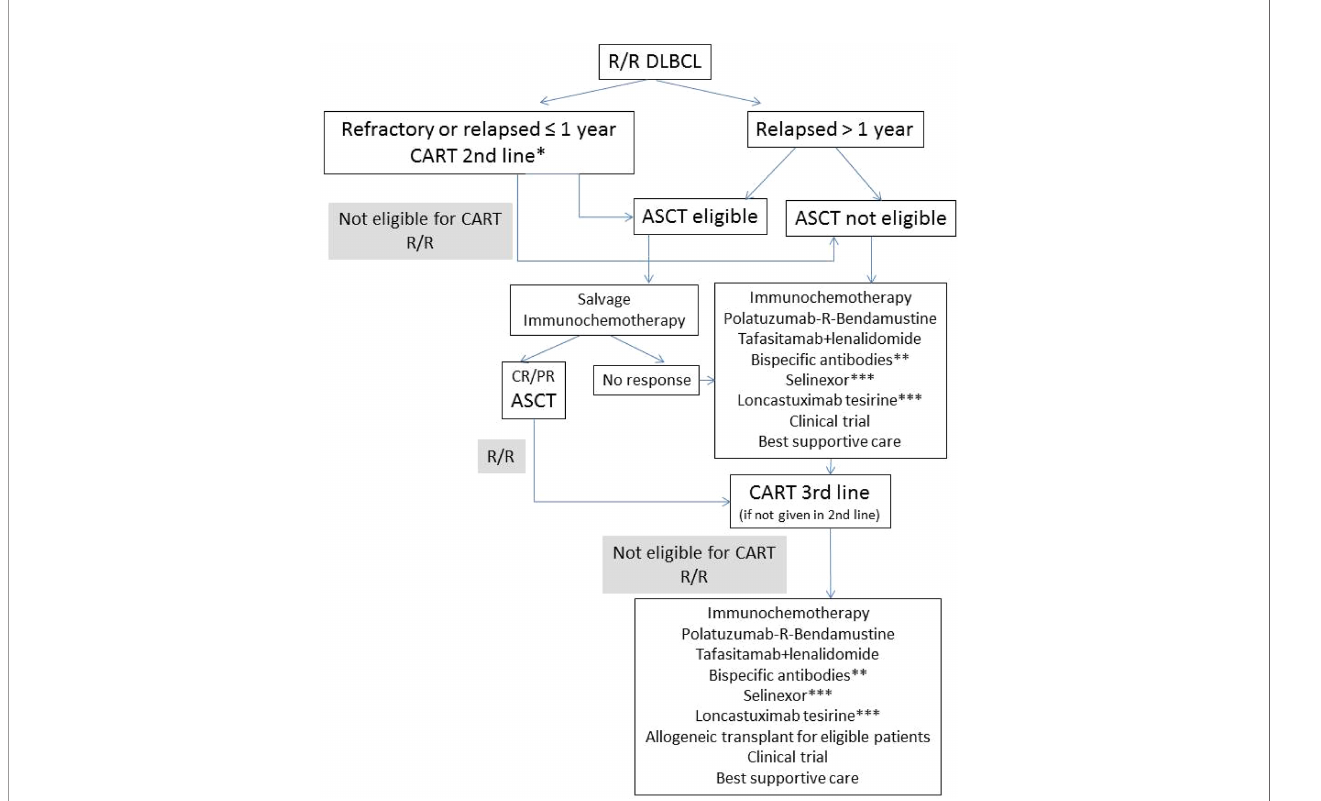
FIGURE 1 | Proposed algorithm for the treatment of R/R DLBCL. R/R, relapsed or refractory; ASCT, autologous stem-cell transplant; CR, complete remission, PR, partial remission; *axi-cel approved by FDA; **currently available only in clinical trials; ***approved by FDA after ≥ 2 lines of previous